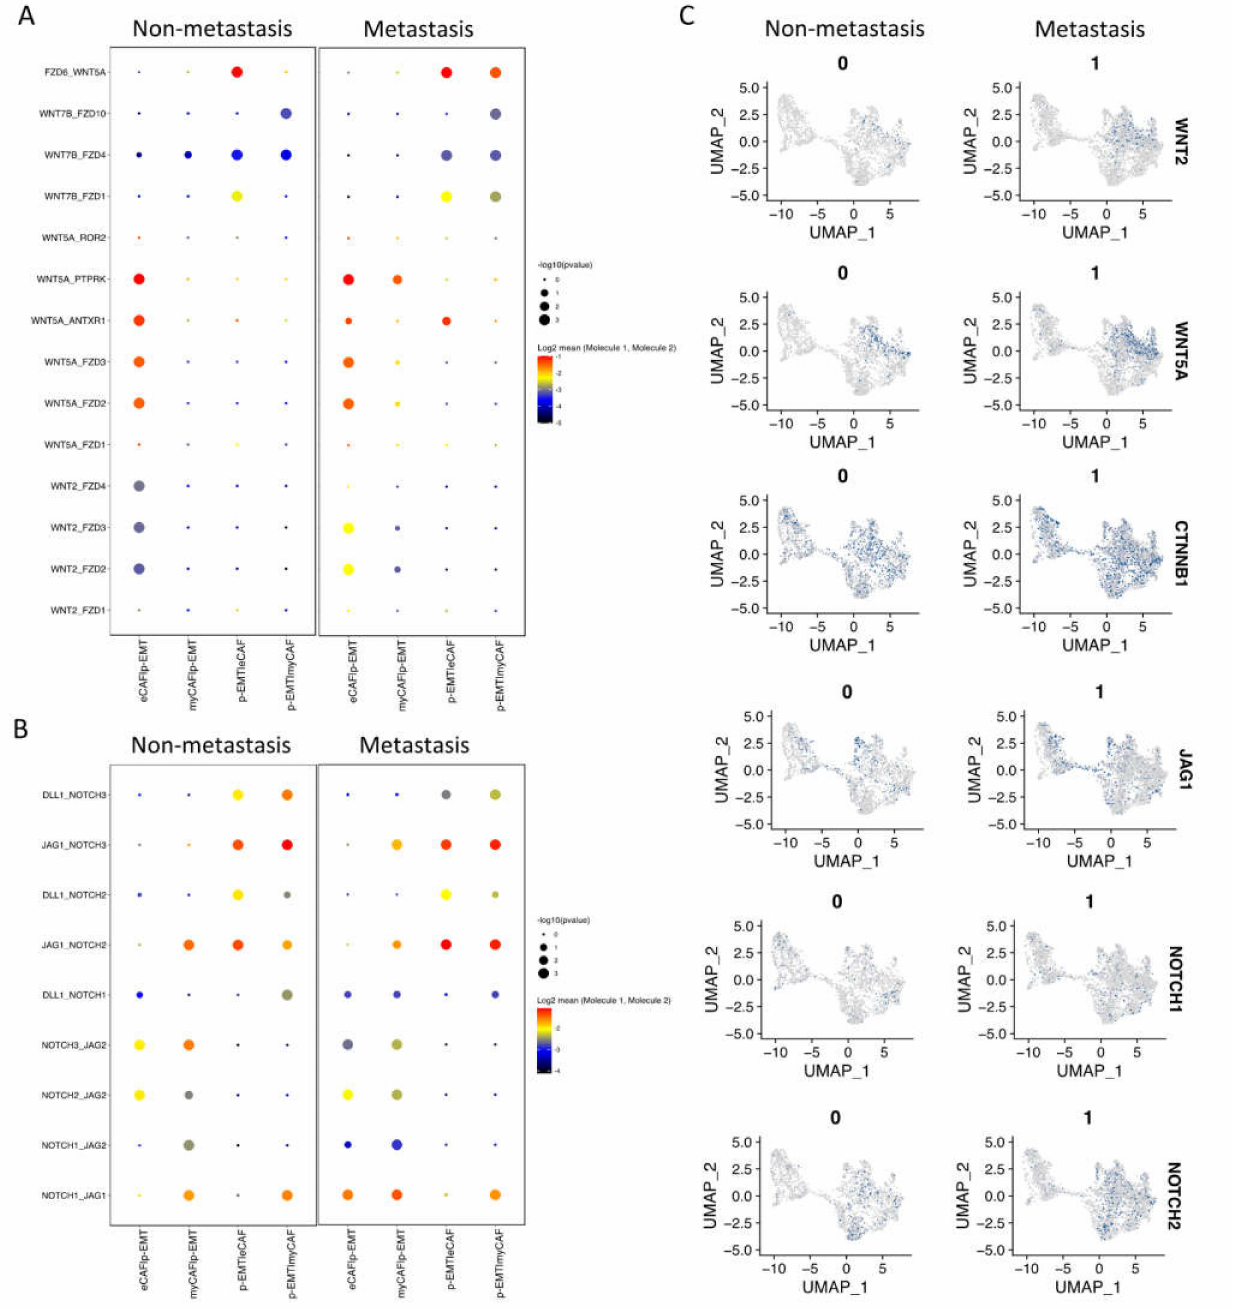
Figure 4. WNT and NOTCH signaling pathways increased in metastasis p-EMT cluster and eCAF/myCAF clusters. ( A ) Significant WNT signaling pathway communications upregulated in metastasis conditions between p-EMT cluster and eCAF/myCAF clusters (with compared non- metastasis condition). ( B ) Significant NOTCH signaling pathway communications upregulated in metastasis condition between p-EMT cluster and eCAF/myCAF clusters (with compared non- metastasis condition). ( C ) WNT and NOTCH signaling pathway-related gene expressions in inte- grated single-cell RNA-seq of fibroblasts and epithelial cells in non- vs. metastasis conditions. 2.4. The p-EMT Tumor Cells—CAFs Communication Highlighted the Different Roles of TNFRSF25 in Non-Metastasis and TNFRSF12A in Non-Metastasis OSCC In addition to the upregulation of integrin and collagen complexes, WNT and NOTCH signaling interactions in non- vs. metastasis conditions between eCAFs/myCAFs